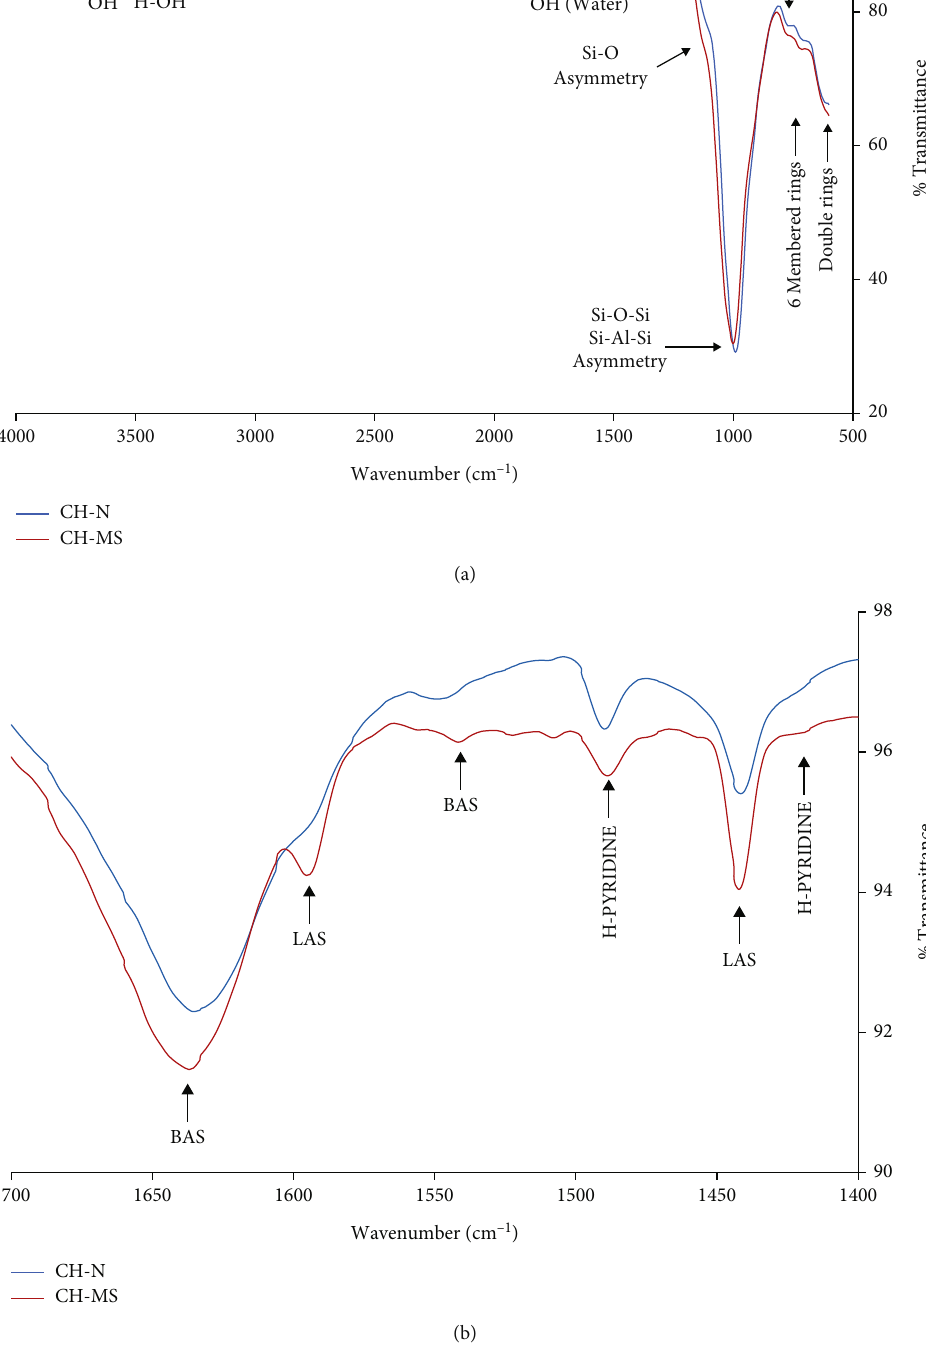
Figure 3: FTIR spectra of CH-N and CH-MS samples (a) without and (b) with loaded